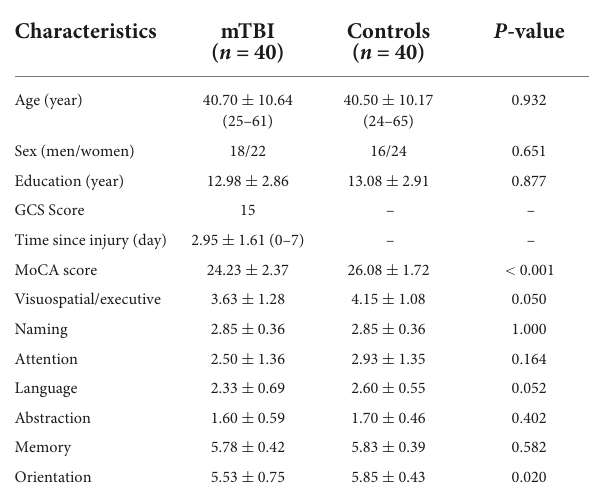
TABLE 1 Summary of demographic characteristic between patients with mTBI and healthy